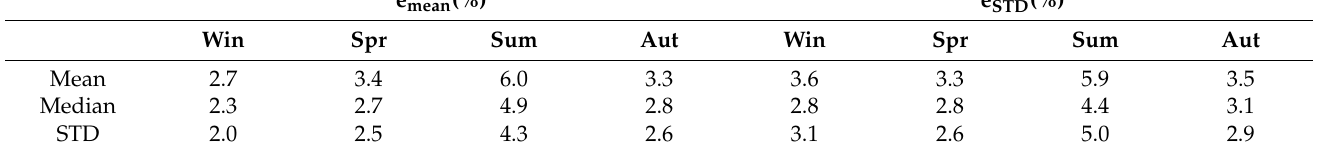
Figure 8. Trends in the number of hours (events) with intense precipitation (greater than 3.6 mm/h), on an annual basis and on a seasonal basis (spring and autumn), for the Busachi case study.